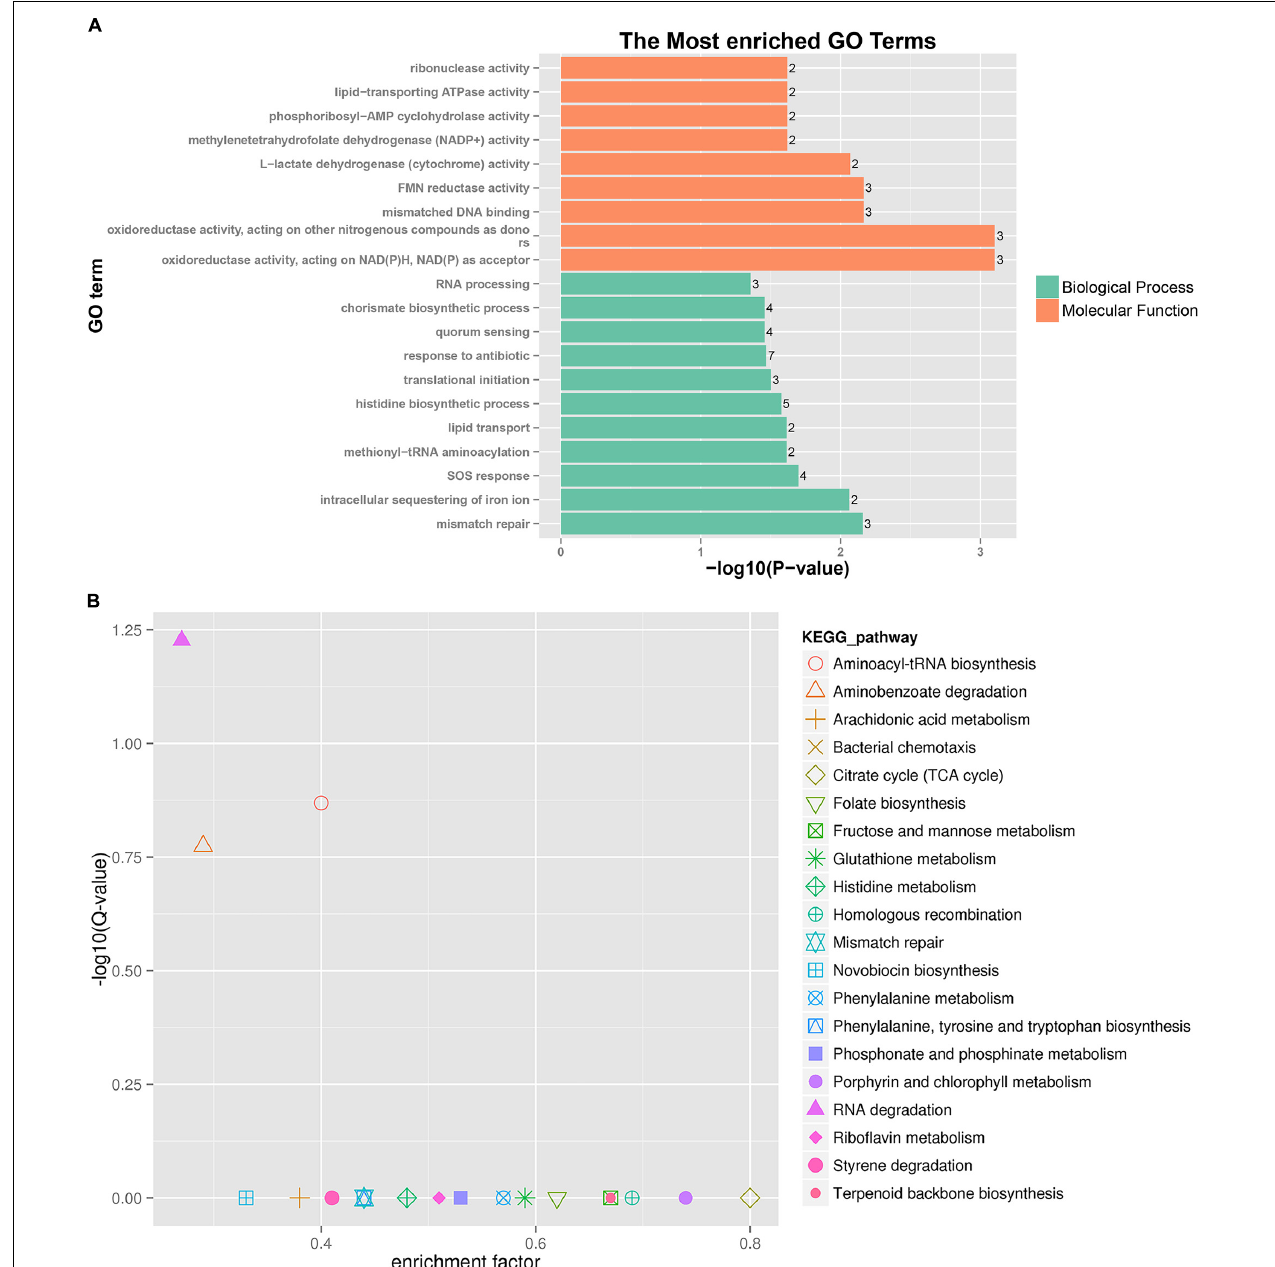
FIGURE 4 | GO and KEGG pathway enrichment analysis of DEGs between HL treatments. (A) GO enrichment. The bigger the value of –log10 ( p -value), the more enriched. p -value < 0.05 is the significant difference, and p -value < 0.01 is the most significant difference. The ordinate is “GO term.” (B) KEGG pathway enrichment. Enrichment factor = Amount of all genes/Amount of DEGs enriched in the pathway in the background gene set. The smaller the enrichment factor, the more significant. The same